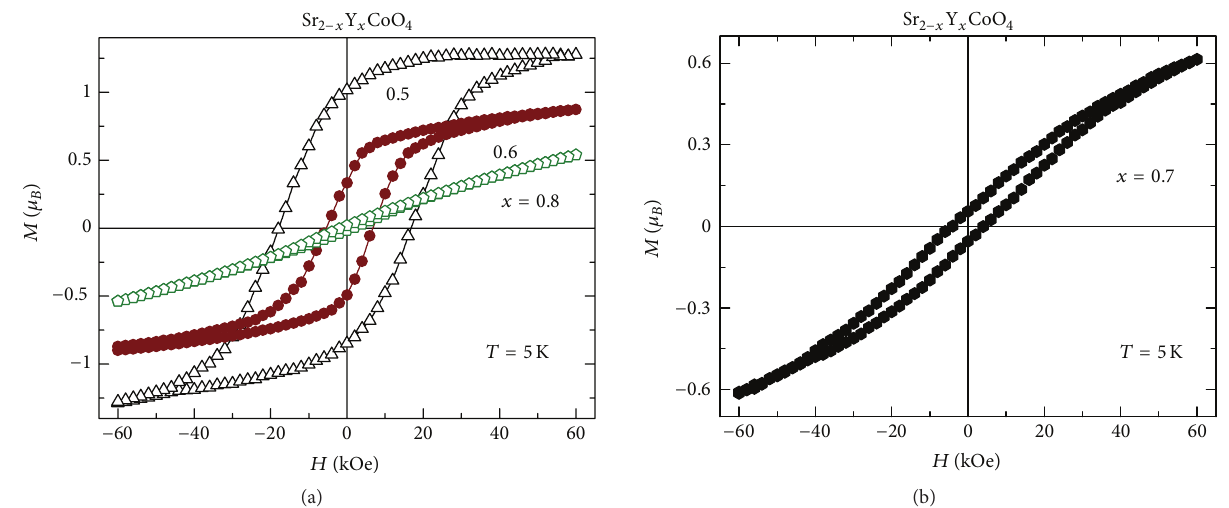
Figure 3: (a) Magnetization hysteresis, 𝑀 , of the Sr 2−𝑥 Y 𝑥 CoO 4 , samples of 𝑥 = 0.50 , 0.60 and 0.80, versus applied field (𝐻) at 𝑇 = 5 K. (b) 𝑀(𝐻) of Sr 1.3 Y 0.7 CoO 4 at 5K. Table 1: Magnetic and electrical parameters of Sr 2−𝑥 Y 𝑥 CoO 4 , 0.50 ≤ 𝑥 ≤ 0.80 . Listed are the Curie-Weiss temperature, 𝑇 𝜃 , the effective